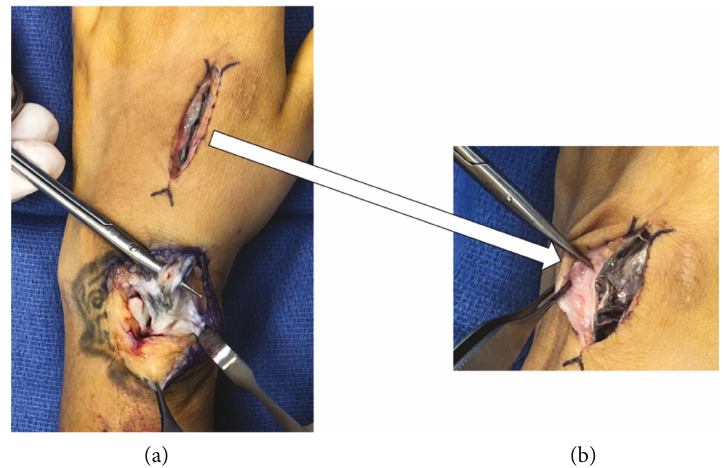
Figure 4: Extensor tendon damage. Metallosis, fraying, and near-complete rupture of the EPL tendon, shown on top of the tenotomy scissors (a). Close-up view of the metallosis as well as the distal EI and ECRL tendon damage over the index metacarpal (b).